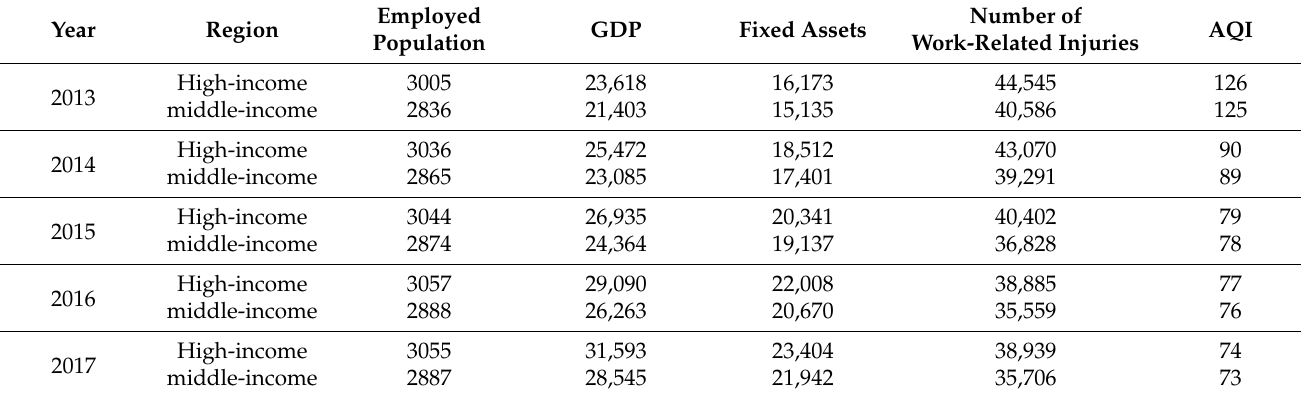
Table 2. Input and output variables from 2013–2017 between high- and middle-income